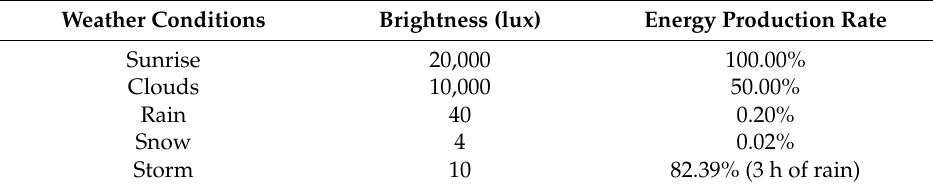
Table 2. Energy production rate according to the